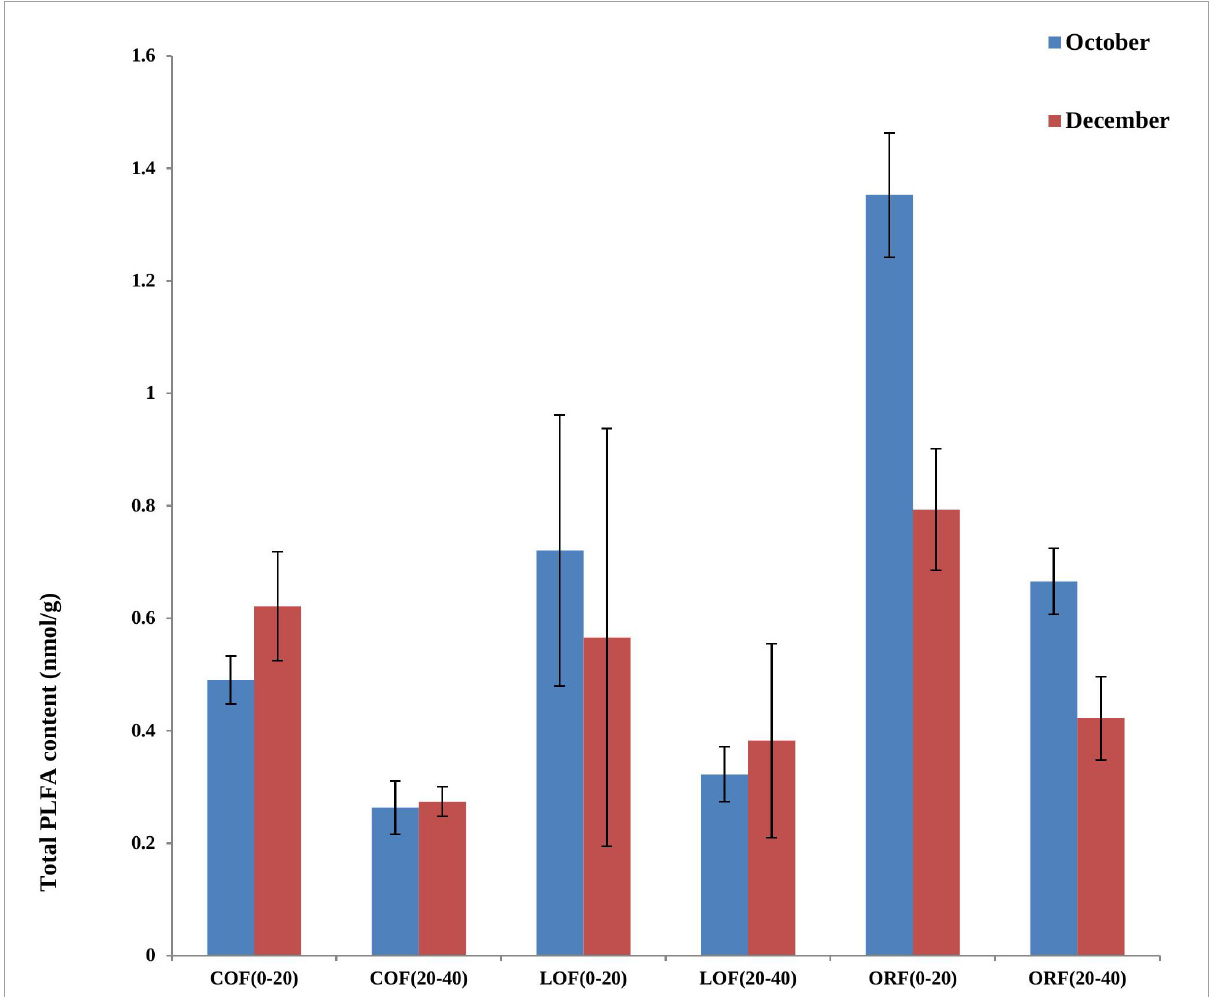
FIGURE2 Effect of different farming practices on total PLFA content of soil within different soil depths during different sampling months. Where, October and December- Months of soil sampling; PLFA, Phospho-lipid fatty acids; COF, Conventional farming; LOF, Low input farming; ORF , Organic farming; 0–20 and 20–40 (cm)—Soil depth from where soil samples were